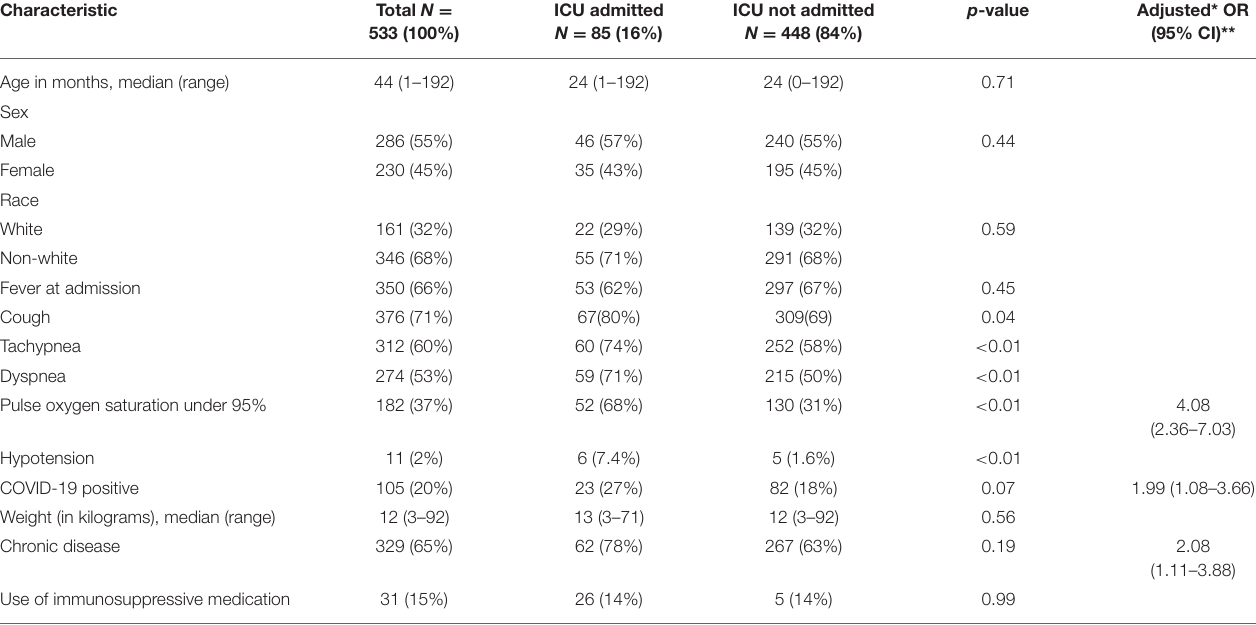
TABLE 5 | Epidemiological data, clinical features and diagnosis confirmation of pediatric patients hospitalized with suspected COVID-19, comparing ICU admitted. Characteristic Total N =